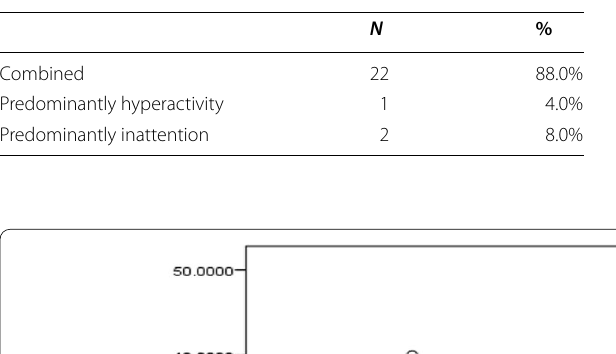
Table 2 Clinical characters of ADHD group